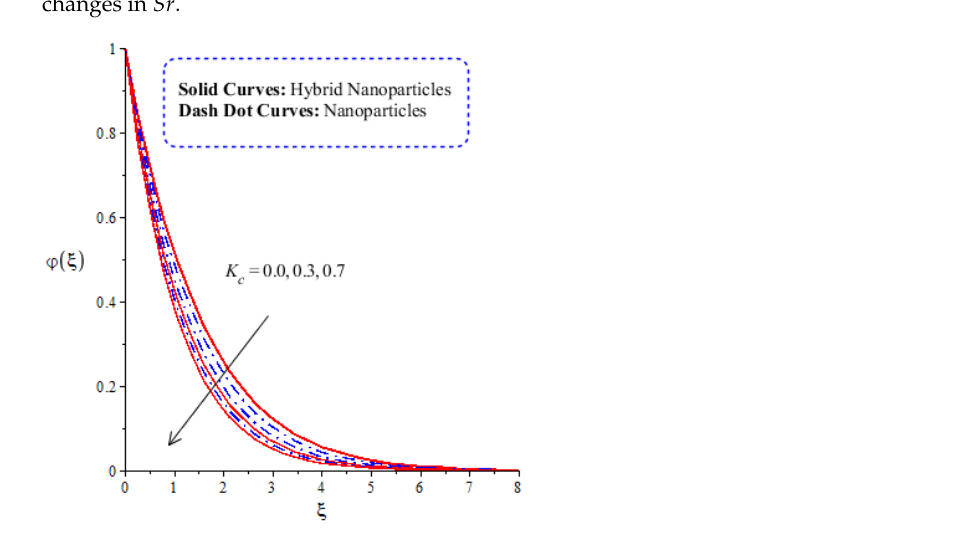
Figure 17. Comparative analysis of concentration in hybrid nanoparticles and nanoparticles with changes in K c .